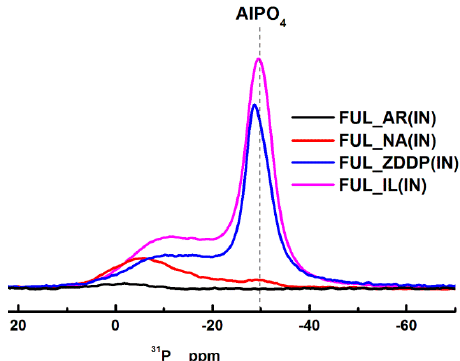
Figure 7. 31 P NMR (nuclear magnetic resonance) spectra of the inlet parts of FUL_AR, FUL_NA, FUL_ZDDP, and FUL_IL.